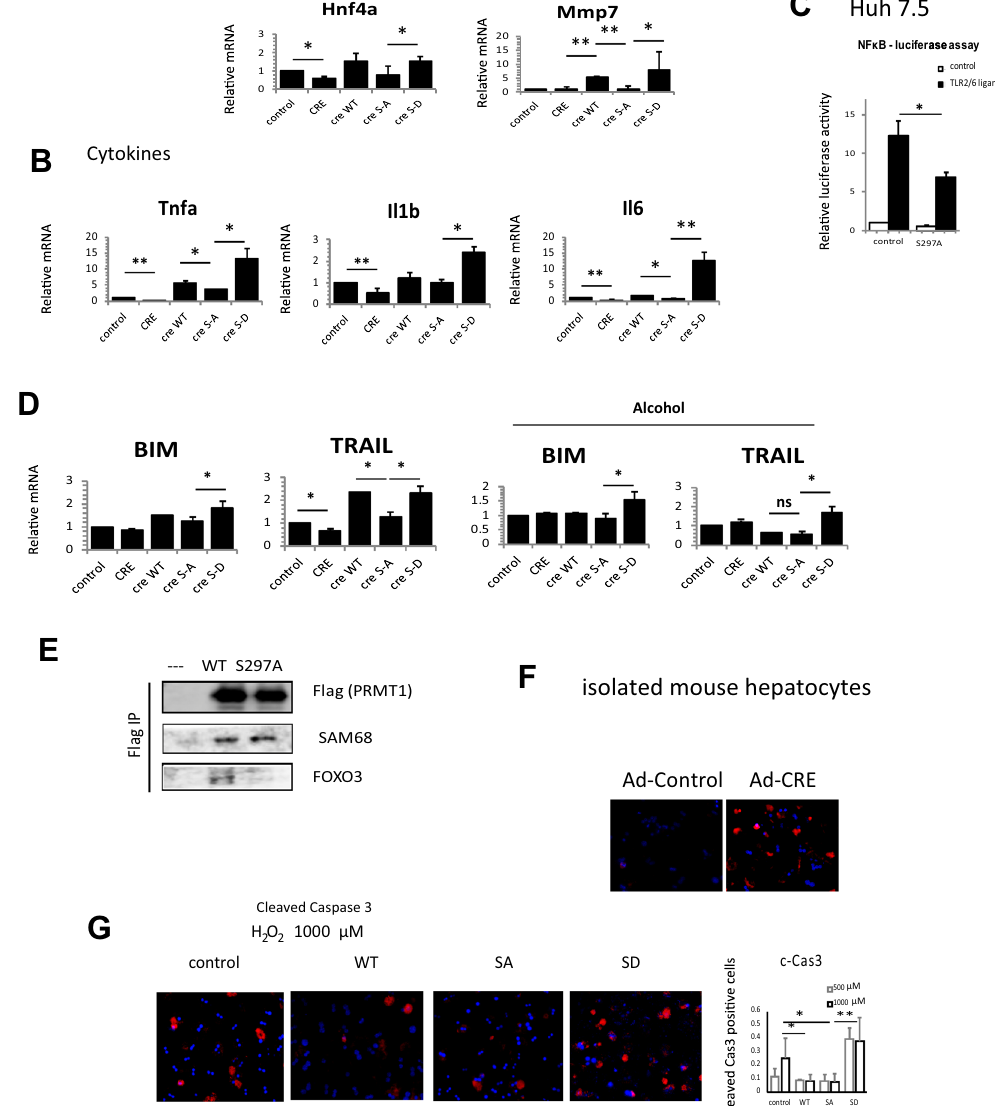
Figure 6. PRMT1 dephosphorylation is required for protection from oxidative stress. (A) Hepatocytes were isolated from PRMT1 floxed mice and treated with Ad-Cre to induce PRMT1 knockout or Ad-control vectors. PRMT1 wild type or S297A and S297D mutants were expressed in PRMT1 knockout hepatocytes to assess the function of S297 phosphorylation. ( A , B ) Relative mRNA expression in these hepatocytes from N = 4–8 independent experiments, data are presented as mean ± SD, ** p < 0.01. ( C) Relative luciferase activity in Huh 7.5 control or expressing S297A PRMT1 in the presence or absence of FSL-1 from N = 3 independent experiments, data are presented as mean ± SD, * p < 0.05. ( D) Relative mRNA expression of apoptosis related genes as in A. from N = 4–8 independent experiments, data are presented as mean ± SD, * p < 0.05. ( E) Wild type or S297A PRMT1 was immunoprecipitated using anti-Flag affinity resin. Huh 7.5 not expressing PRMT1 was used as a negative control. Co-immunoprecipitated proteins were analysed by western blot analysis using anti-Flag (PRMT1), anti-FOXO3 or anti-SAM68 antibodies. ( F) Hepatocytes were isolated from PRMT1 floxed mice and treated with Ad-Cre to induce PRMT1 knockout or Ad-control vectors. Cells were treated with H 2 O 2 for 24 h and stained for cleaved-Caspase 3 to detect apoptotic cells. ( G) Hepatocytes expressing PRMT1 wild type, S297A, S297D or control vector were treated with 0.5 or 1 mM H 2 O 2 for 24 h and stained for cleaved- Caspase 3 to detect apoptotic cells. Right. Average number of cCas3 positive cells (of total number of cells) in N = 3 independent experiments, * p <